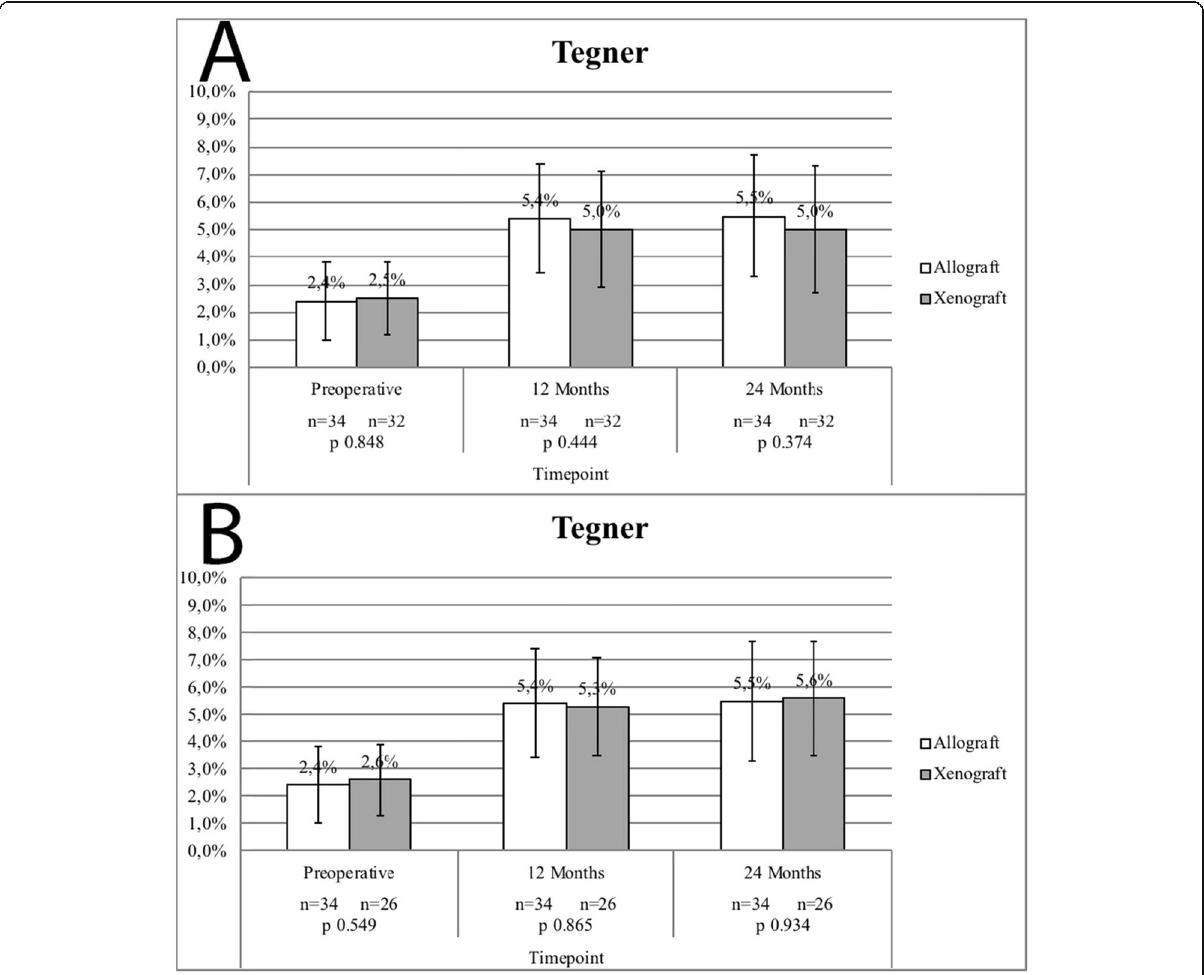
Fig. 5 Tegner Scores - a , Missing/Contaminated Graft Subjects Included (LOCF); b , Missing/Contaminated Graft Subjects Excluded. No statistically significant differences were reported between study groups in both analysis (intention-to-treat vs. per protocol)